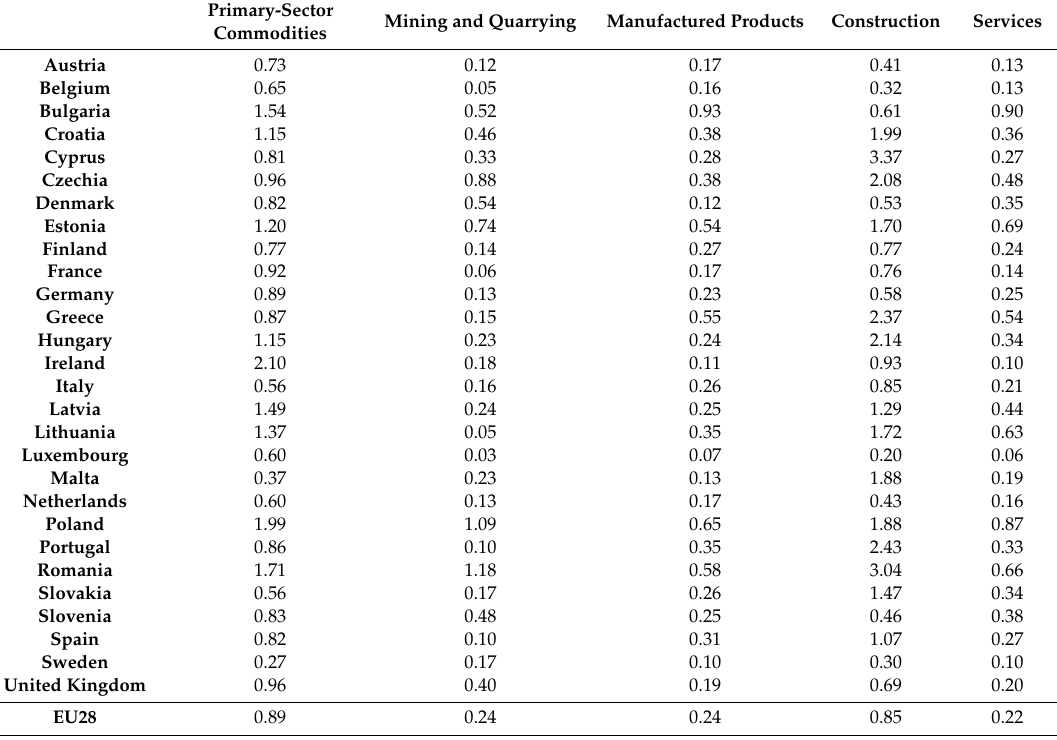
Table A4. Average GHG emission (1000 tonnes) reduction per 1 million euros of demand reduction. Primary-Sector